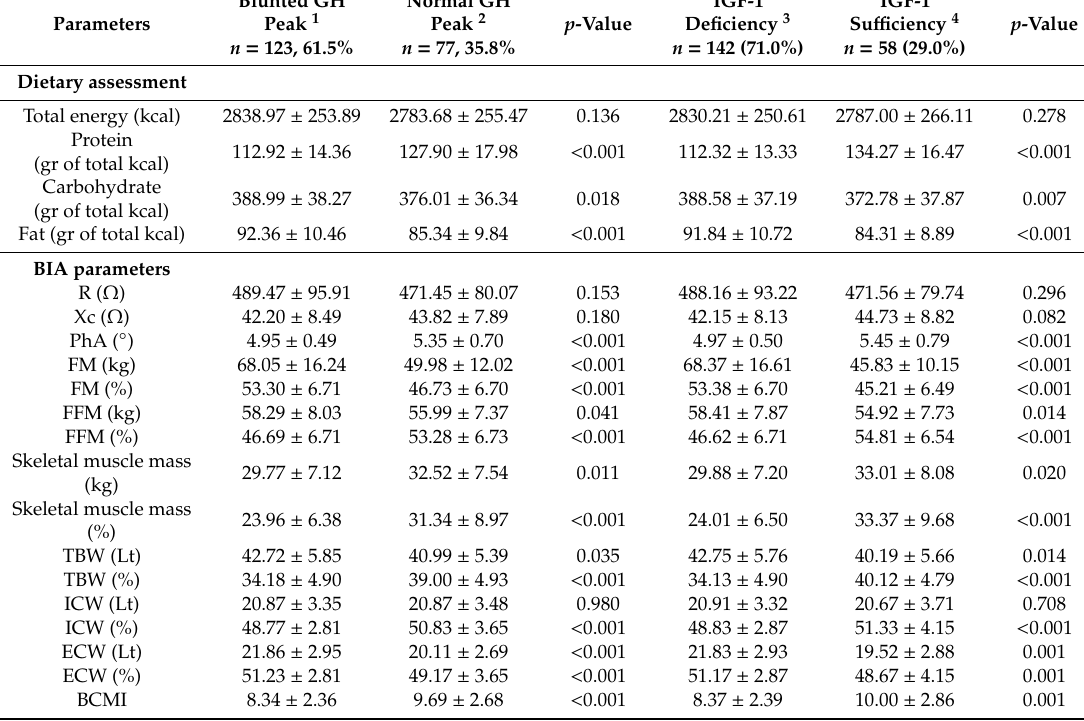
Table 4. Total energy and macronutrient intake of 200 adult females with obesity included in the study divided according to blunted GH peak or IGF- 1